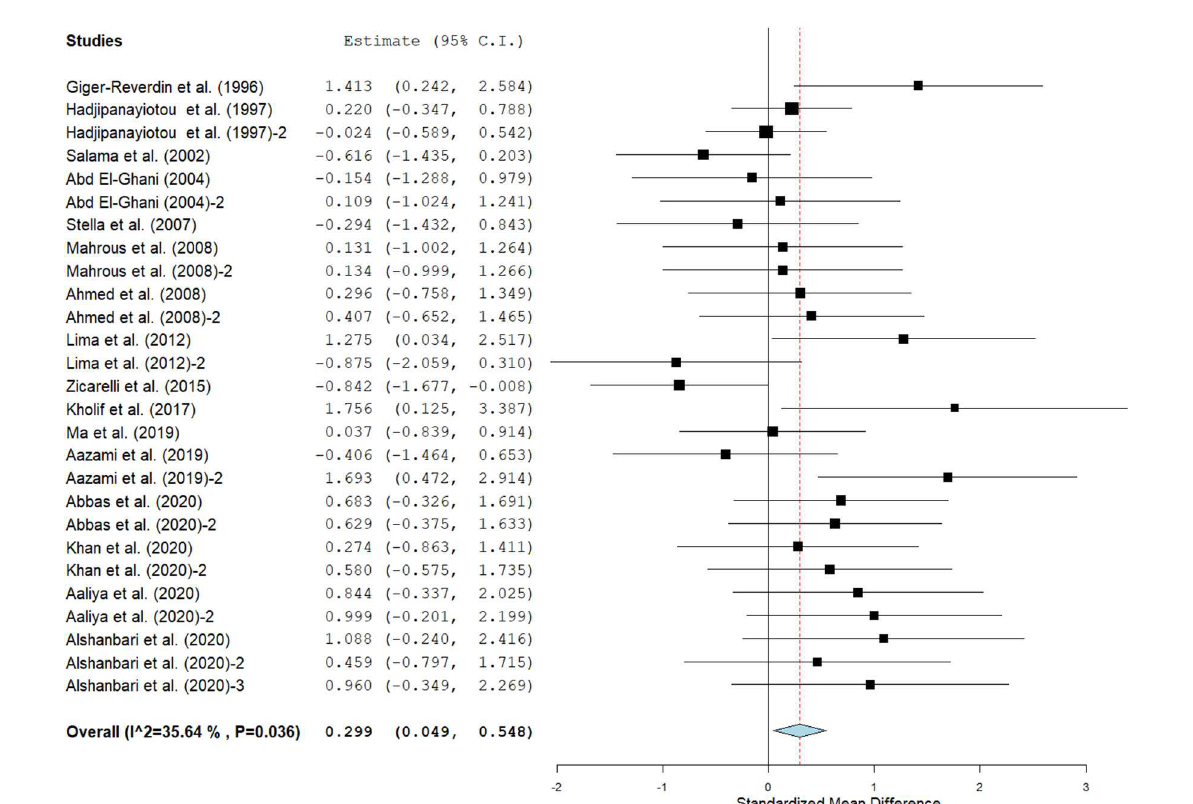
FIGURE5 Influence of SC on milk fat yield in lactating goats. The error bars connote the SMD of each trial, while the upper and lower 95% CIs for the effect size are the line that joined the individual square box. The thick vertical line is the line of no effect (SMD = 0), which suggests no effect of dietary SC intervention on milk fat yield. The sky-blue diamond at the base of the plot indicates the pooled SMD with its width representing the 95% confidence intervals for the effect size. The points to the right of the line of no effect suggest an increase in milk fat yield. The points to the left of the line of no effect connote an increase in milk fat yield. I 2 is the Inconsistency